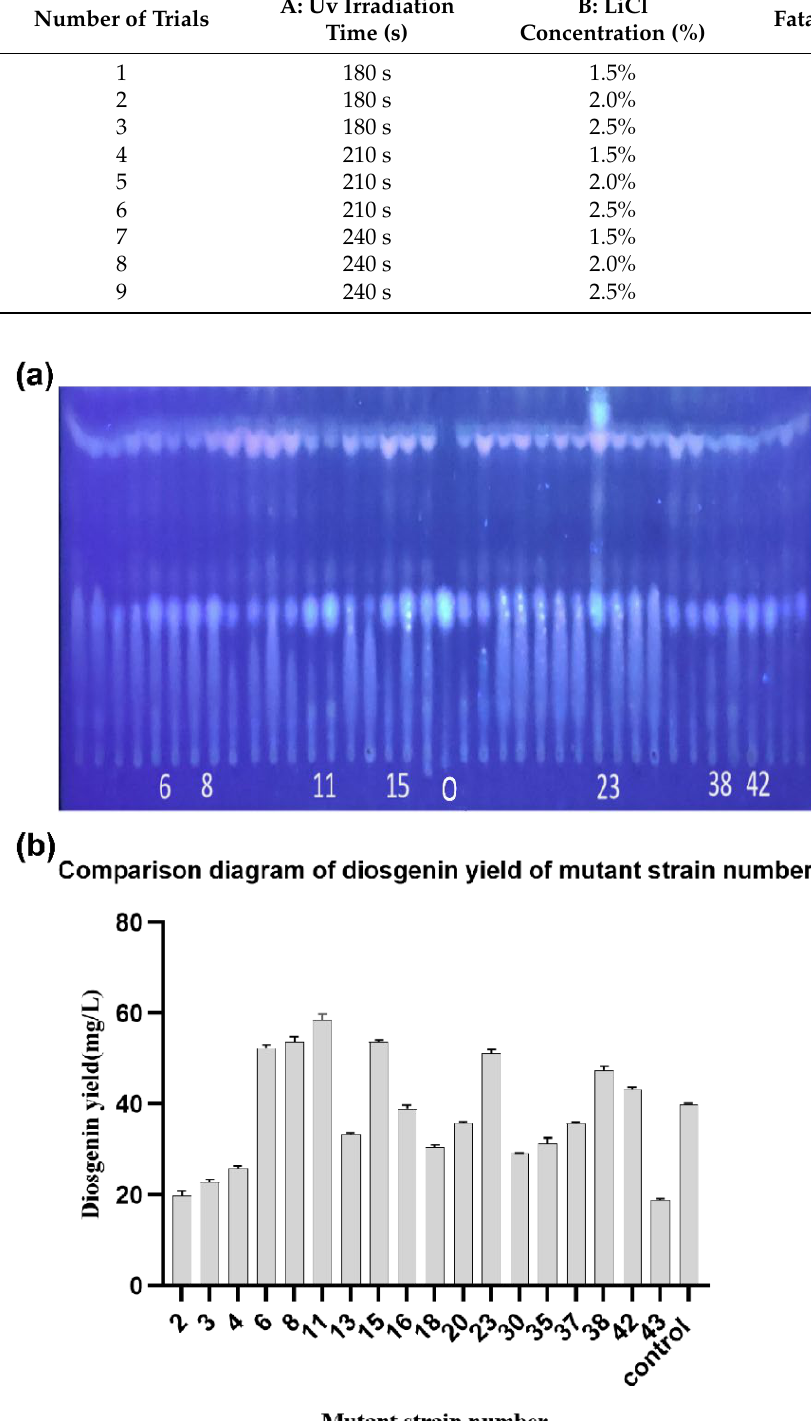
Figure 3. ( a ) Thin layer chromatogram of diosgenin from screened mutant strains. Strain 0 was the unmutagenized strain SY fx2 13.2 as the control. Strain 6, 8, 11, 15, 23, 38, 42 were strains with higher yield of diosgenin than the control strain. ( b ) Comparison diagram of diosgenin yield of mutant strains. Unmutagenized strain SY fx2 13.2 used as the control